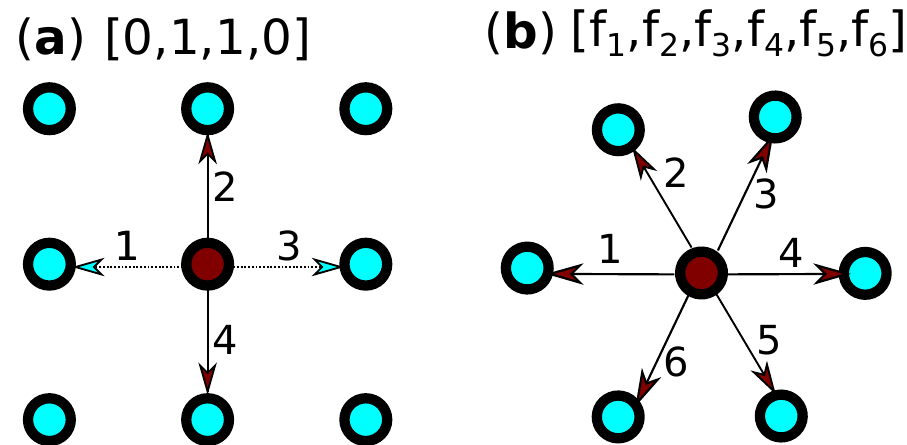
Figure 2. Two example lattices that can be used in LGA and LBM. The arrows show the lattice vectors, along which particles can move from the red point to its neighbours (blue). The vector for the red lattice point is shown on top of each graph: ( a ) example of the velocity vector for LGA; and ( b ) example of the velocity vector for